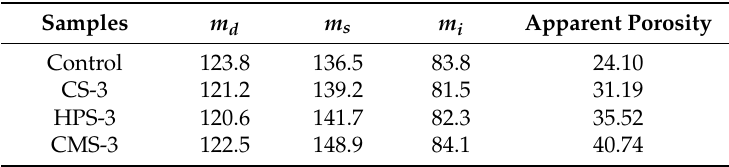
Table 4. The value of m d (g), m s (g), m i (g) and apparent porosity (%) of 200 ◦ C-heated specimens immersed in water for 24 h.